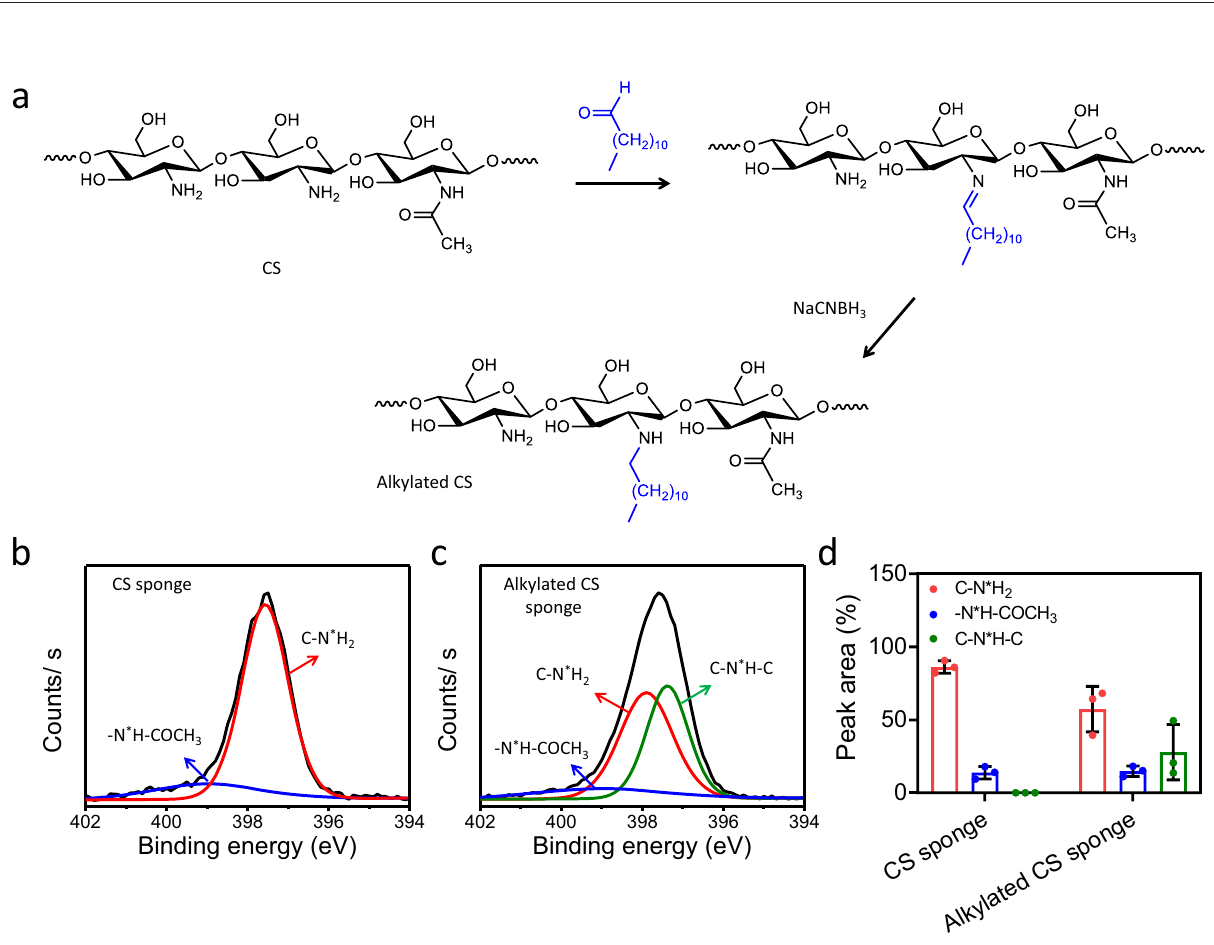
Fig. 2 Chemical characterization of the MACSs. a Modi fi cation of the CS sponge with DA in the presence of NaCNBH 3 as a reducing agent. b , c Representative XPS spectra showing N1 s peak of the CS and alkylated CS sponges. d The area of N1 s peaks with different chemical states in the CS and alkylated CS